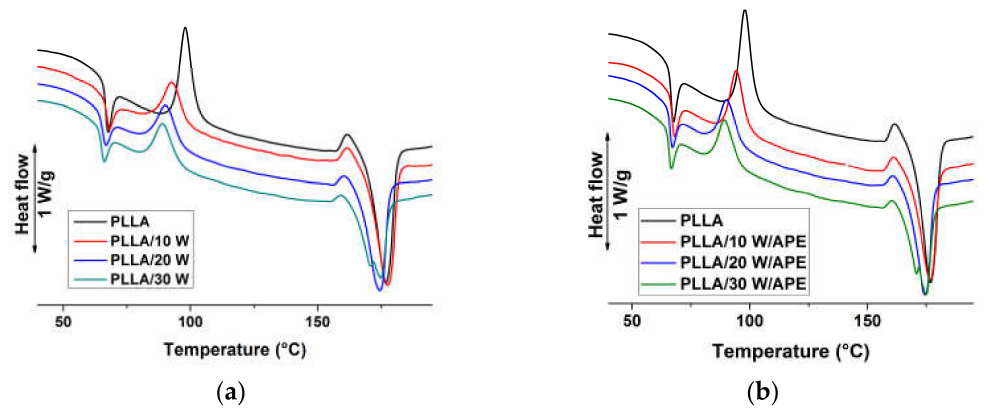
Figure 1. Heat flow rate plots of PLLA and PLLA / wood composites of the indicated compositions upon heating at 10 K / min. ( a ): PLLA / wood composites and ( b ): PLLA / wood / APE composites. Exotherm